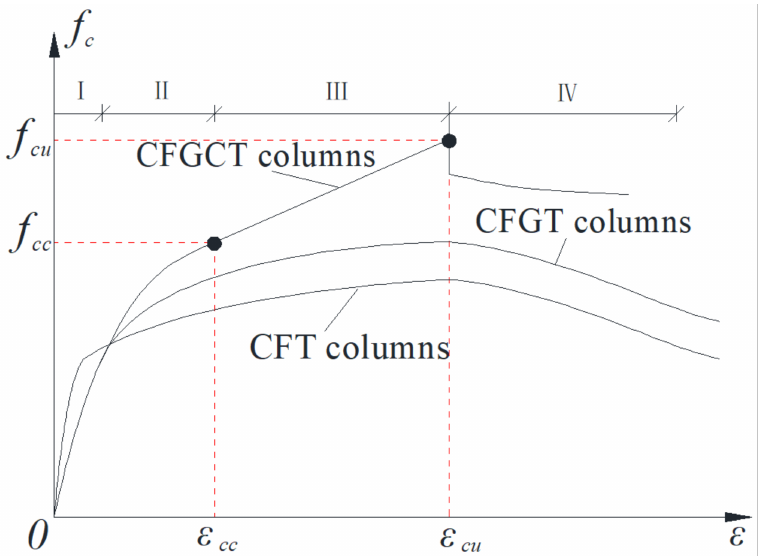
Figure 12. Stress-strain curve models of confined